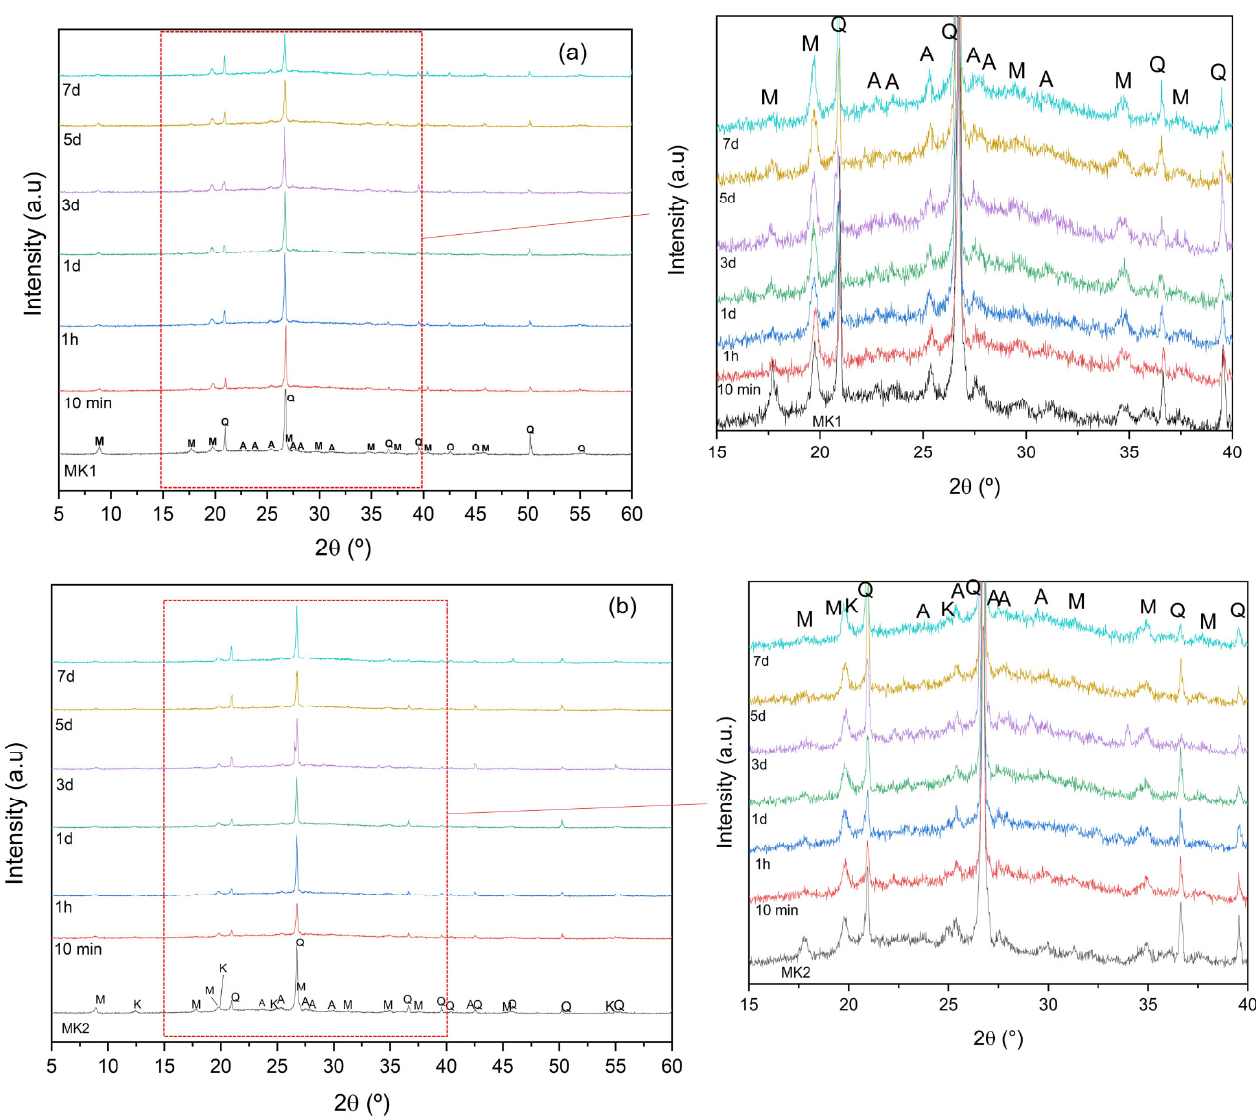
Figure 4. X-ray diffraction patterns for ( a ) MK1 and ( b ) MK2 and for the respective MK pastes as a function of geopolymerization time. (Key: Q—quartz (SiO 2 ); M—muscovite mica (KAl 3 Si 3 O 10 (OH) 2 ); A—albite (NaAlSi 3 O 8 ); K—kaolinite (Al 2 Si 2 O 5 (OH) 4 ).